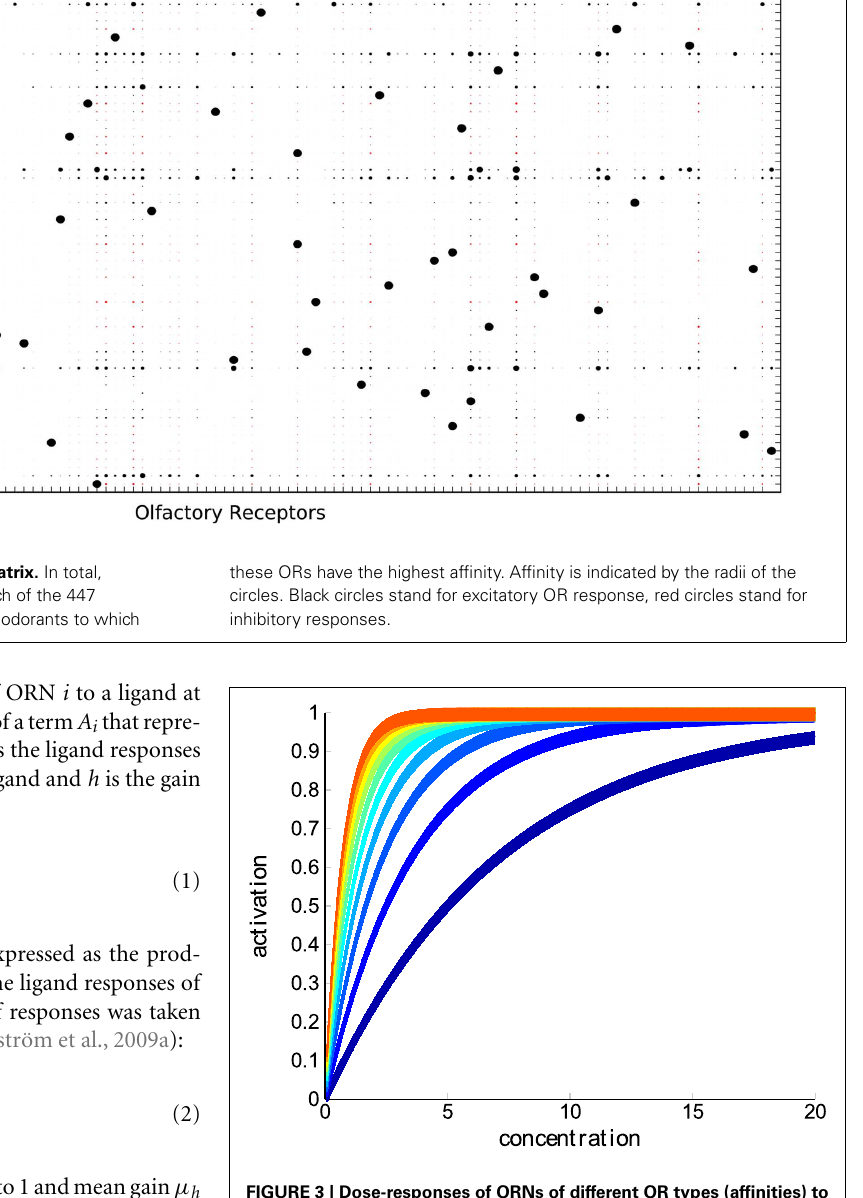
FIGURE 3 | Dose-responses of ORNs of different OR types (affinities) to a single ligand at linearly increasing concentrations. Compare to Eq.